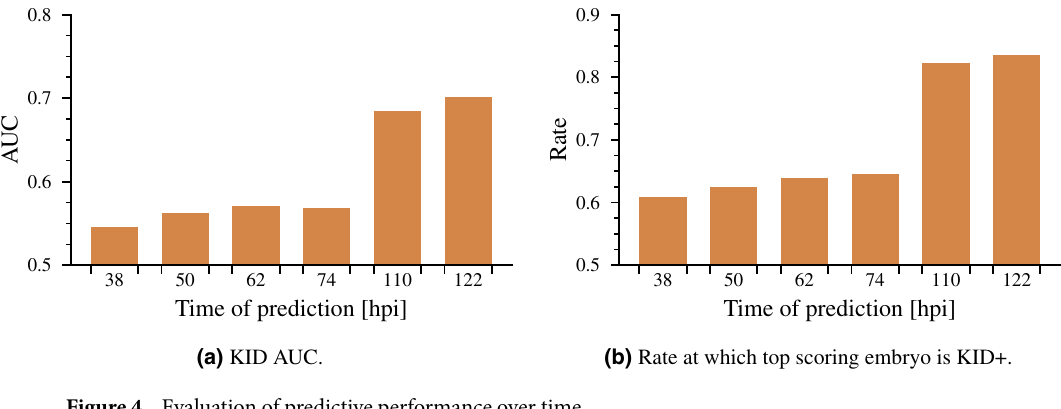
Figure 4. Evaluation of predictive performance over